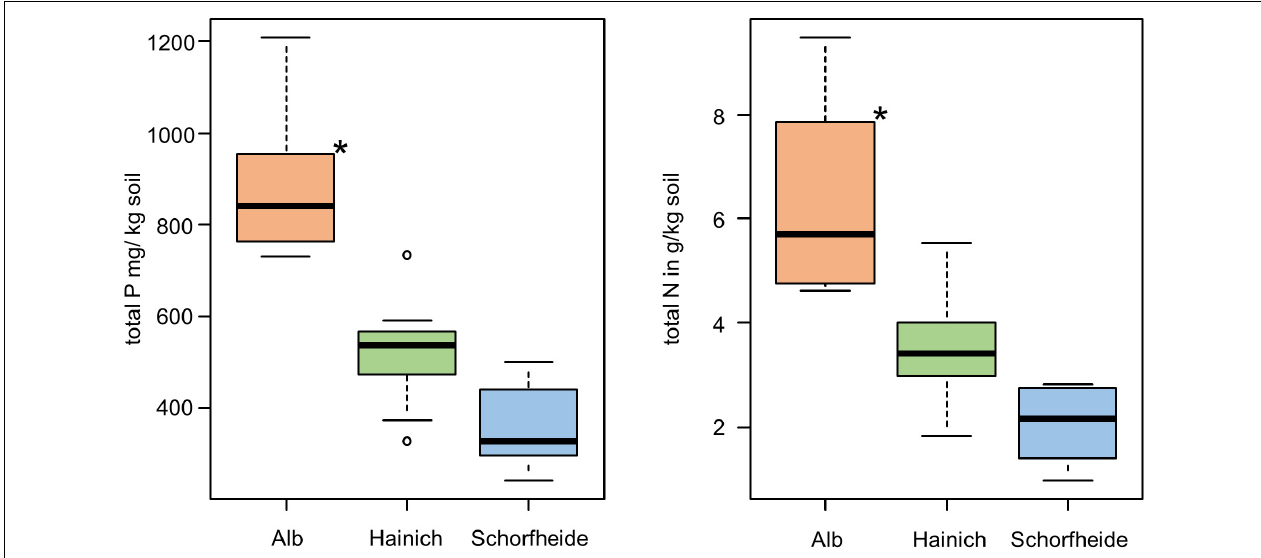
FIGURE 1 | Boxplot of total P content (left) and total N (right) in biocrusts of three sampling sites; significant differences are indicated by asterisks (ANOVA, Tukey post hoc ); n = 9 for each sampling site.